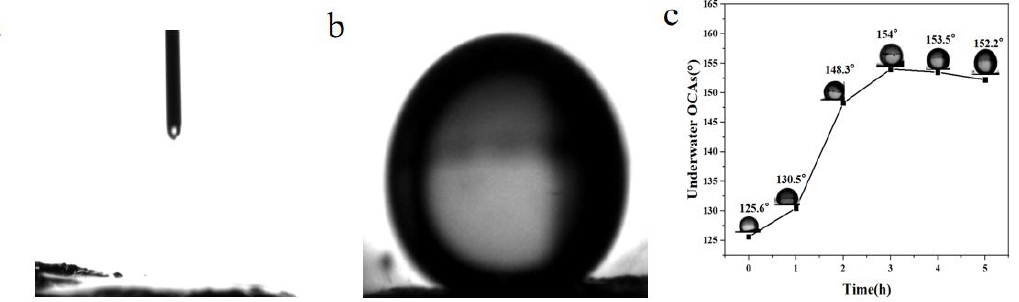
Figure 6. ( a ) Contact angle image of water is 0°. ( b ) Underwater oil contact angle is 156.5°. ( c ) The change of oil contact angle under UV light in 0~5